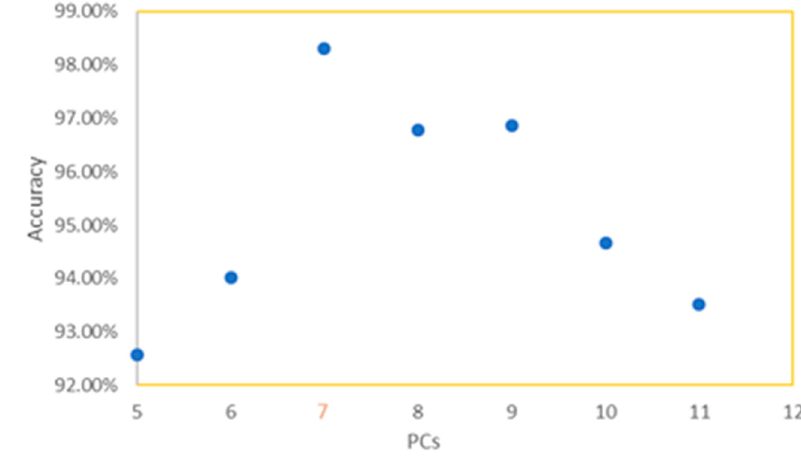
Figure 13. Indian pines dataset OA changes with the training set selection ratio. PCs: principle components.